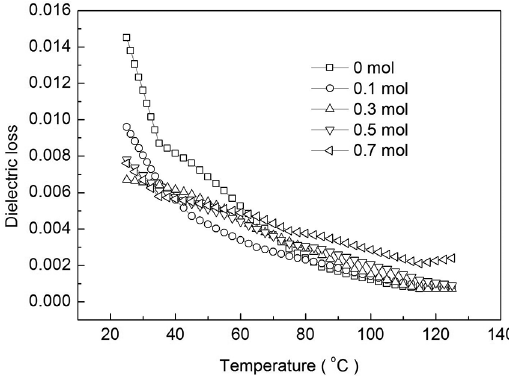
densities show the maximal value for the samples sintered at 1280 °C, 1300°C and 1330°C. The room dielectric constant can reach to 4500 or more for the sample with 0.5mol% sintered at 1300 o C, and the variation of dielectric loss with temperature is more stable for Yb O -doped BZT10 ceramics, 2 3 with the increase of Yb O content, T rises at first, and when 2 3 c x exceeds 0.1 mol%, T shifts towards to lower temperature c with the Yb O concentration increasing, which proves that 2 3 Yb O doping has a great influence on the dielectric properties 2 3 in BZT10 ceramics. T rises from 55 o C for the sample sintered c at 1250 o C to 82 o C for the sample sintered at 1280 o C in the beginning, and then T shifts towards the lower temperature c with the sintering temperature